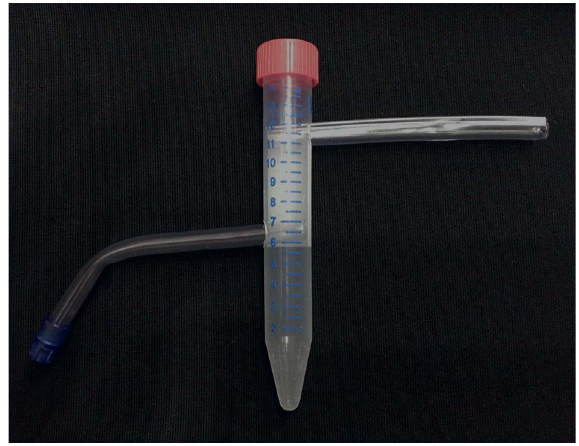
Figure 1. Special disposable sialometer according to Serratine et al.